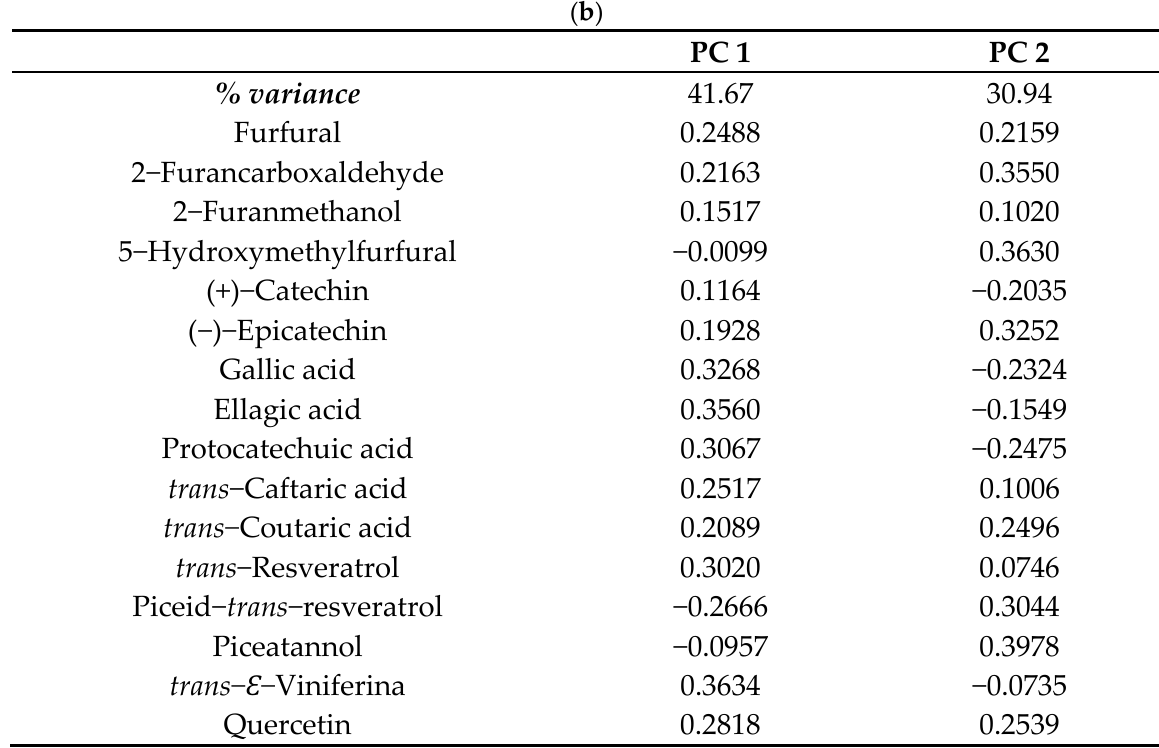
Figure 1. Principal component analysis (PCA) results carried out with phenolic and furans composition. ( a ) Projection of wine samples in the plane formed by the two main components; ( b ) weights of the variables in the first two principal components.